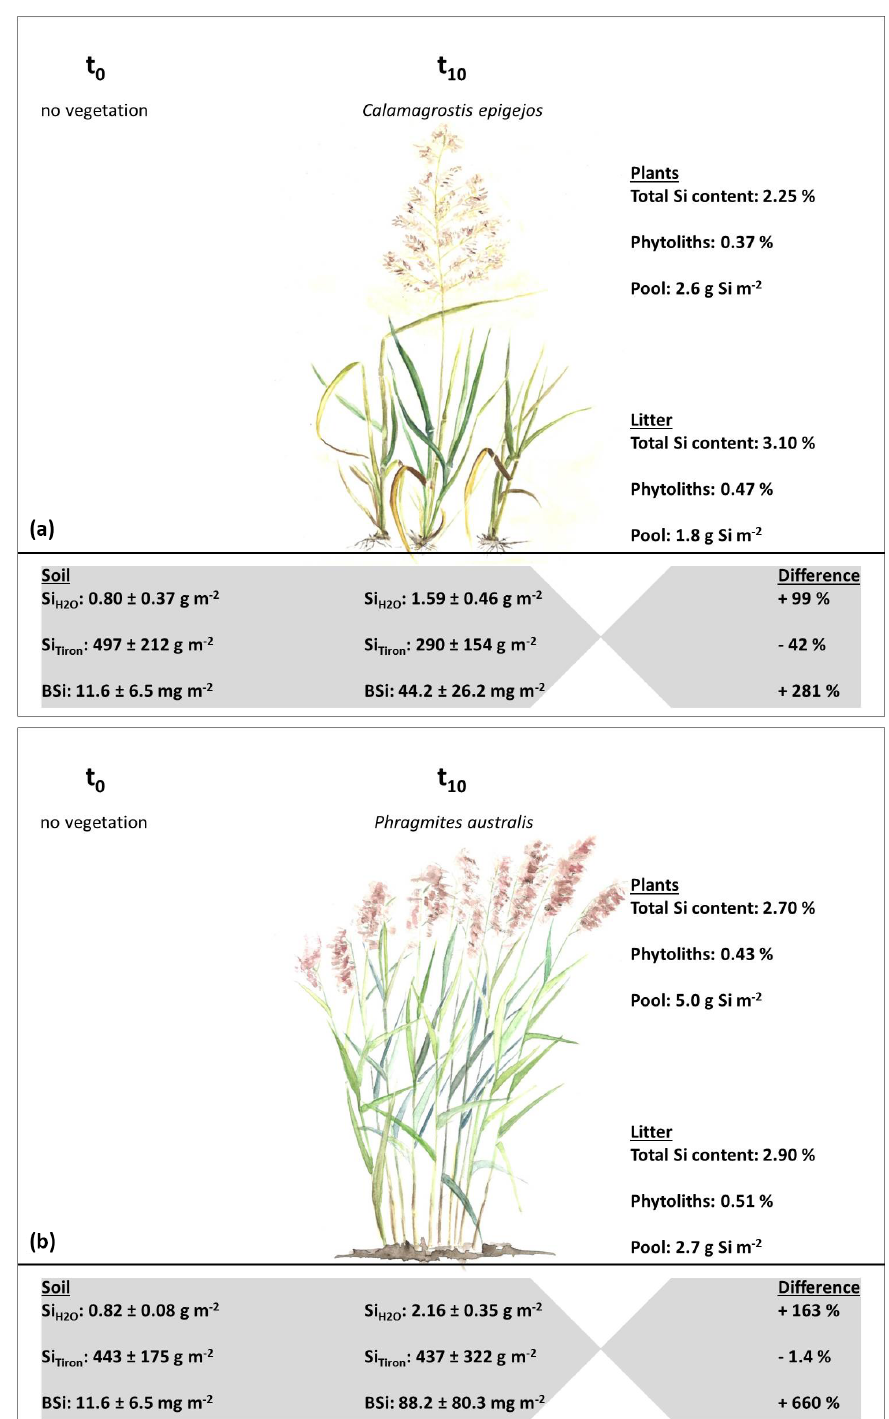
Figure 6. Comparison of water-soluble Si (Si H ), amorphous Si (Si Tiron ) fractions and total BSi in soils (means ± standard deviation, 2 O upper 5cm), where Calamagrostis epigejos (a) and Phragmites australis (b) became dominant. Data are given for t 0 (no vegetation) and t 10 ( C. epigejos , P. australis ). For t 10 total plant Si contents, extracted phytogenic Si (phytoliths) contents and Si pools for C. epigejos and P. australis (plants and litter) are stated in addition. Paintings are from Cornelia Höhn,